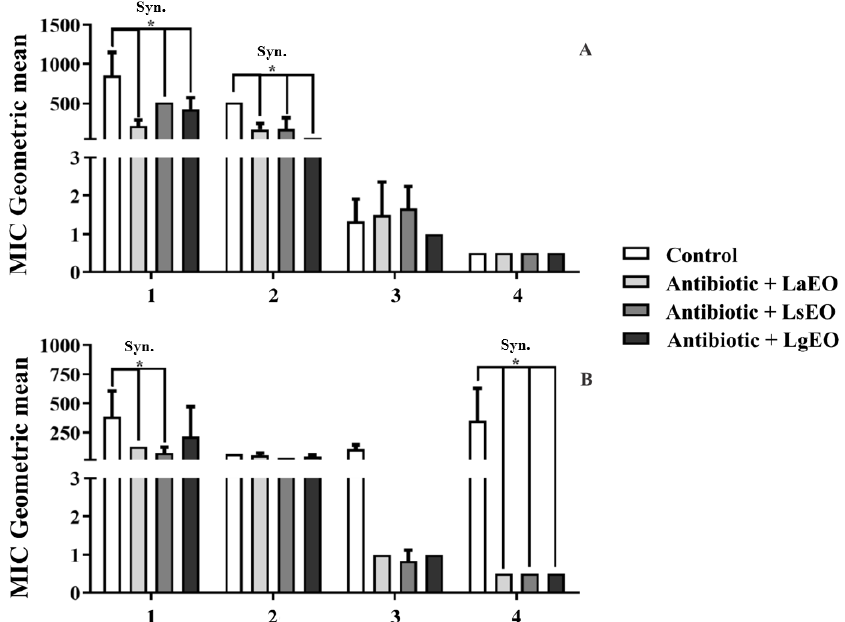
Figure 2. Effects of the essential oils of L. alba (LaEO), L. sidoides (LsEO), and L. gracilis (LgEO) on the antibiotic activity of amikacin (1), gentamicin (2), benzylpenicillin (3), and cephalothin (4) against Staphylococcus aureus Sa 358 ( A ) and Escherichia coli Ec 27 ( B ). Syn.: synergism; *: p < 0.05 (ANOVA and Bonferroni’s post-test).